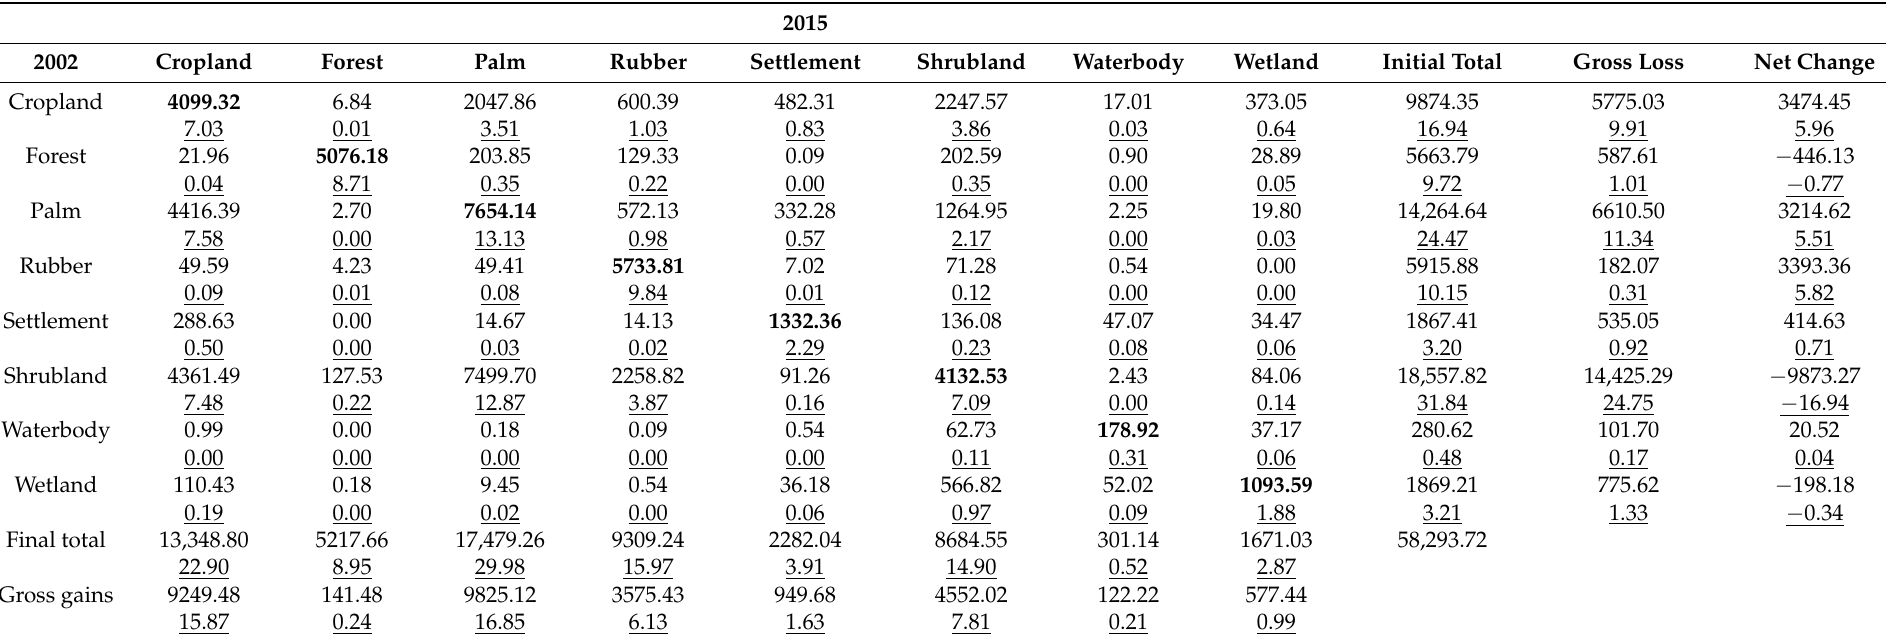
Table A2. Cross tabulation matrices for 2002–2015 area in ha (top values), percentage of total land area (bottom value underlined); the diagonal (in bold) values indicate the persistence of land cover